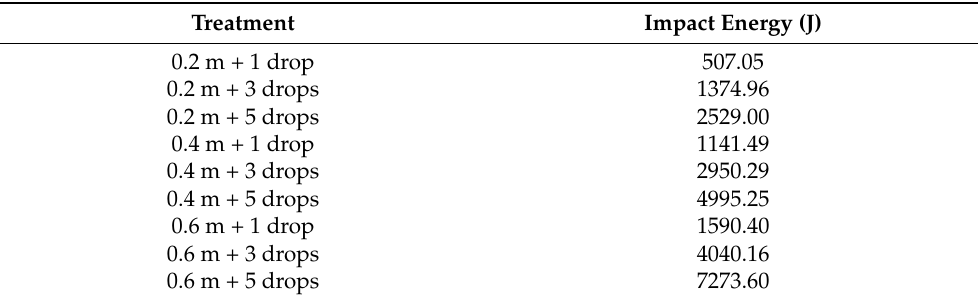
Figure 1. Experimental setup of simulated impact testing in guava ( A ) with stainless-steel ball (250 g, diameter 8 cm) ( B ), adapted following the method of [33]. Table 2. Impact energy for three drop heights (0.2, 0.4, and 0.6 m) and number of drops (1, 3, and 5 times).